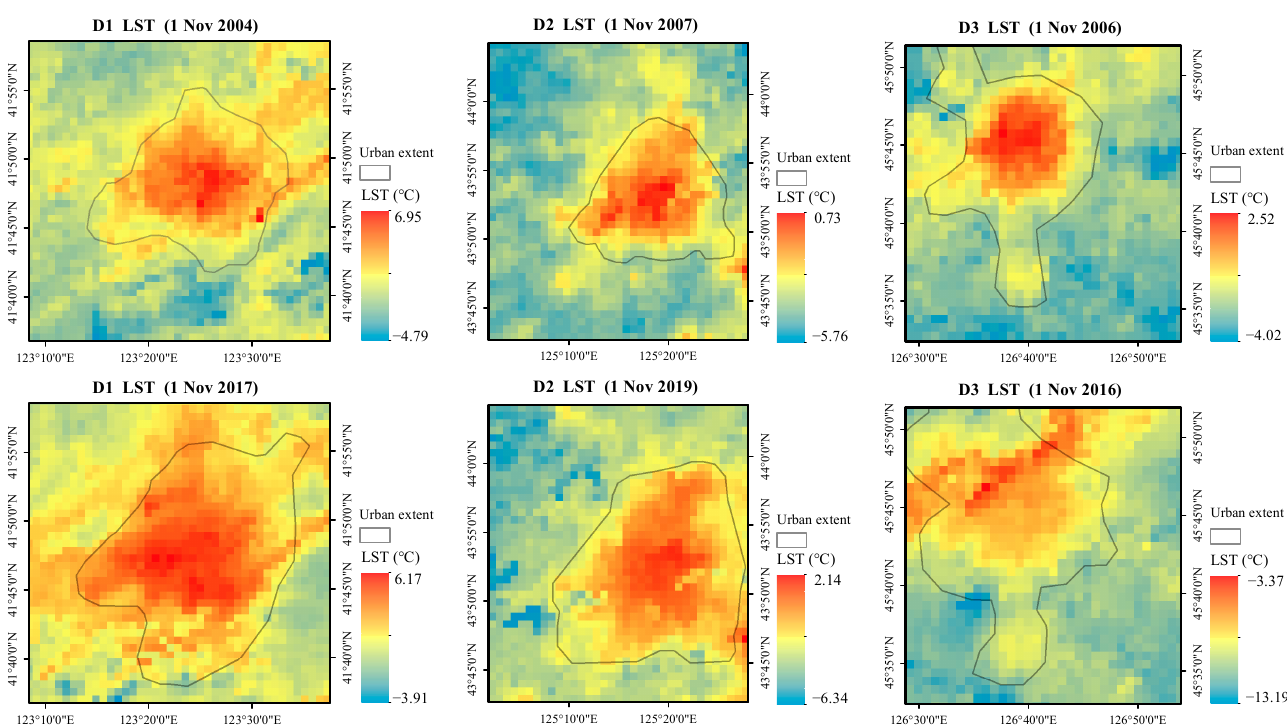
Figure 4. Changes in the spatial distribution of the daily land surface temperature at night.